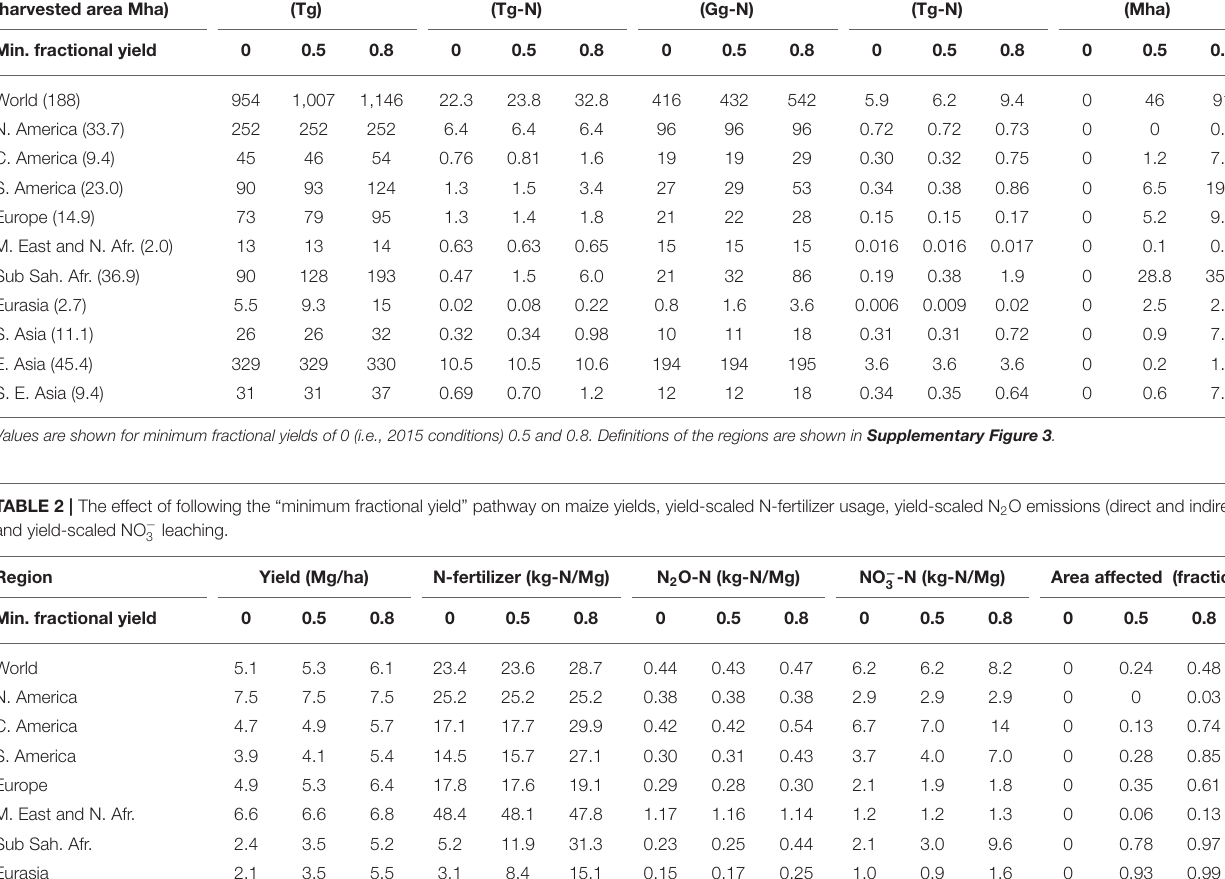
TABLE 1 | The effect of following the “minimum fractional yield” pathway on maize production, N-fertilizer usage, direct and indirect N 2 O emissions, NO − 3 leaching and the affected harvested area. Region (harvested area Mha)